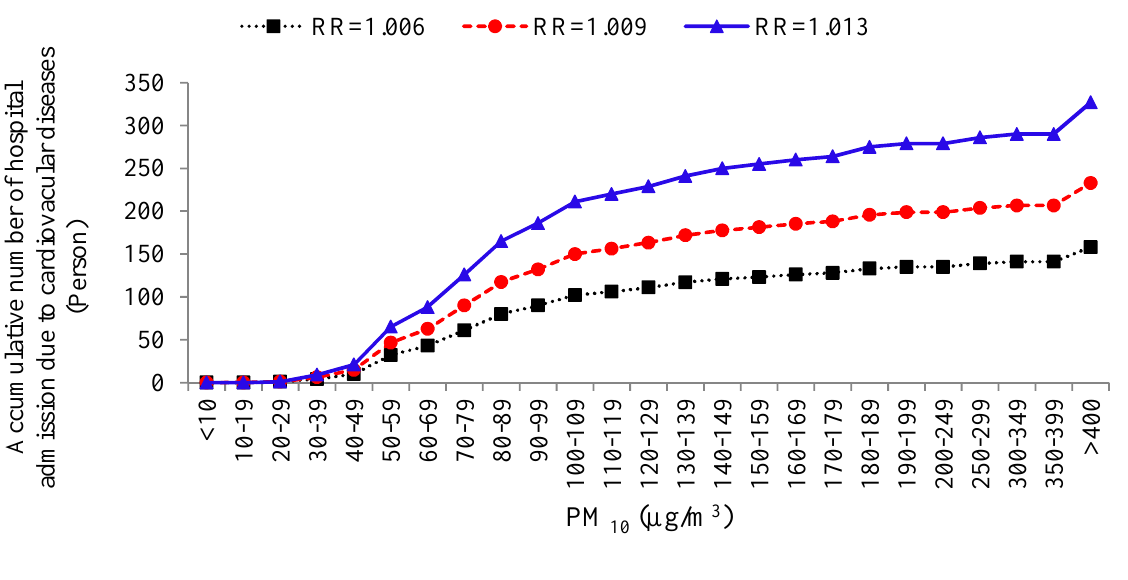
Figure 4. Accumulative number of hospital admission due to cardiovascular diseases attributed to PM10 based on PM10 concentration in Kermanshah